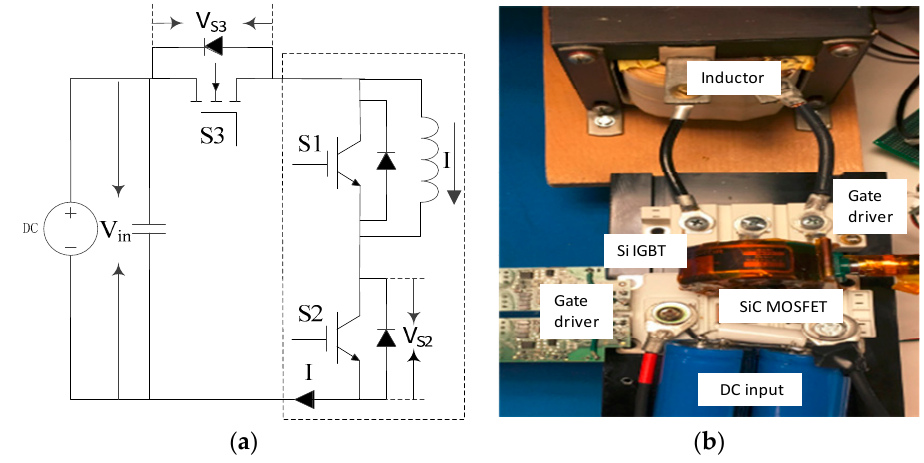
Figure 3. Double Pulse Test (DPT) for the hybrid switches ( a ) DPT Circuit; and, ( b ) DPT platform.